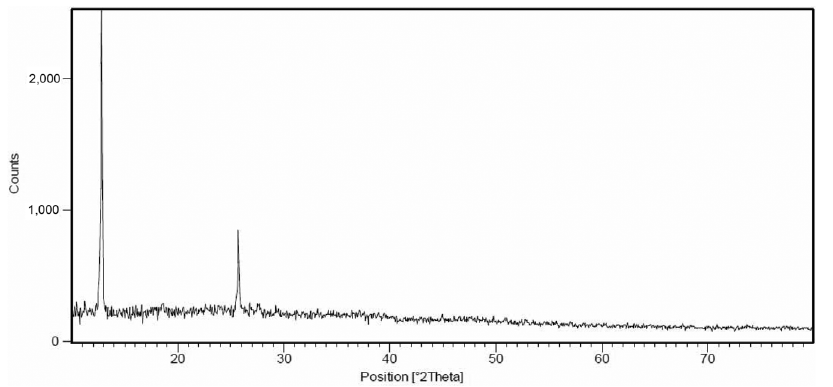
Figure 2: XRD pattern of the as-synthesized posnjakite nanoparticles.